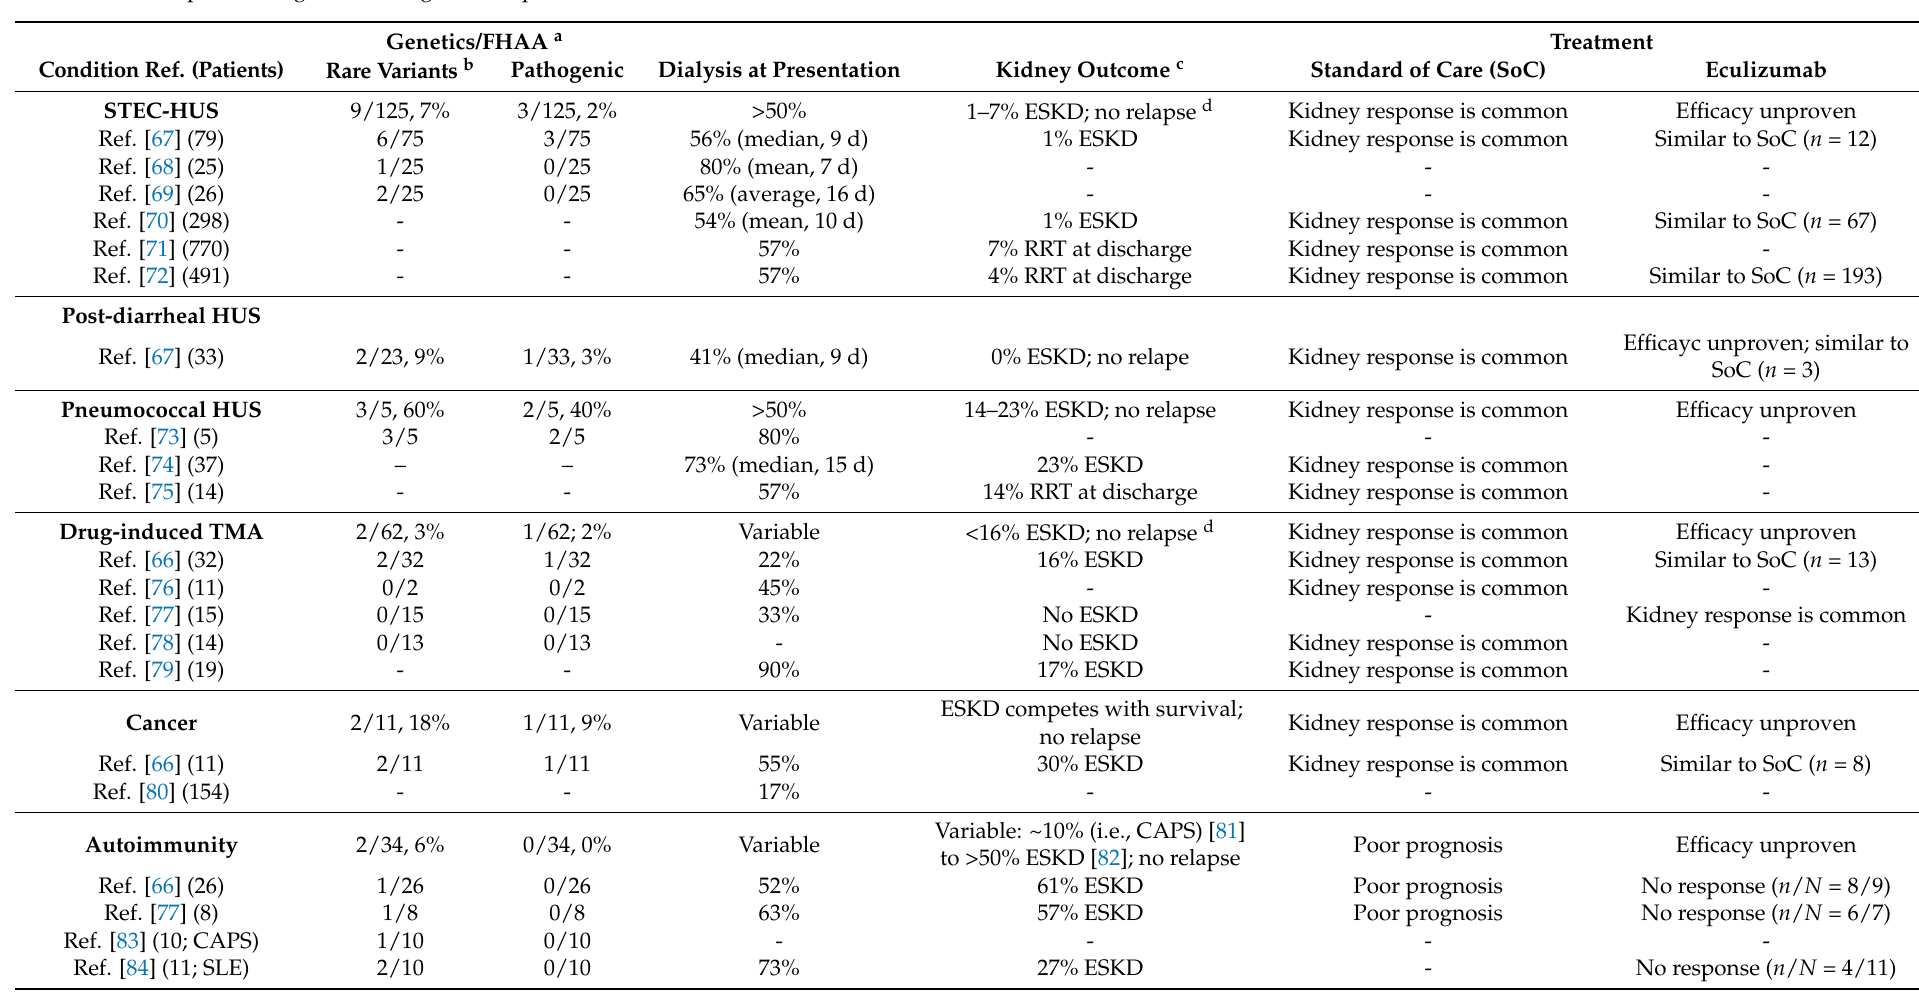
Table 2. The prevalence of rare variants in complement genes (i.e., CFH , CFI , CD46 , CFB , C3 , THBD , and CFHR1 - CFHR5 ) and disease course in patients with secondary TMA confirm normal complement regulation. Single case reports have not been